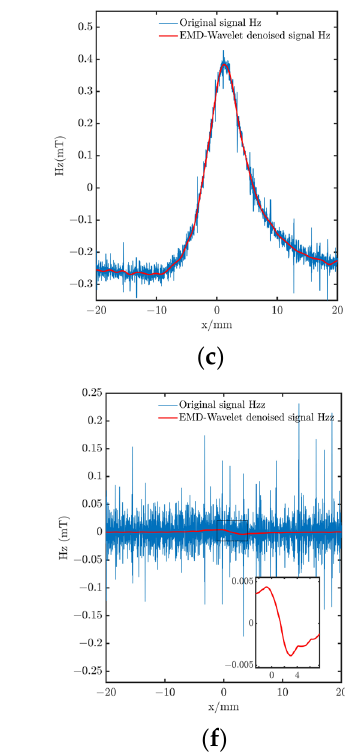
Figure 9. Comparison of EMD-wavelet threshold denoising effects. ( a ) Comparison of normal component signals. ( b ) Comparison of tangential component signals. ( c ) Comparison of horizontal component signals. ( d ) Comparison of gradient values of normal component signal. ( e ) Comparison of gradient values of tangential component signal. ( f ) Comparison of gradient values of horizontal component signal.